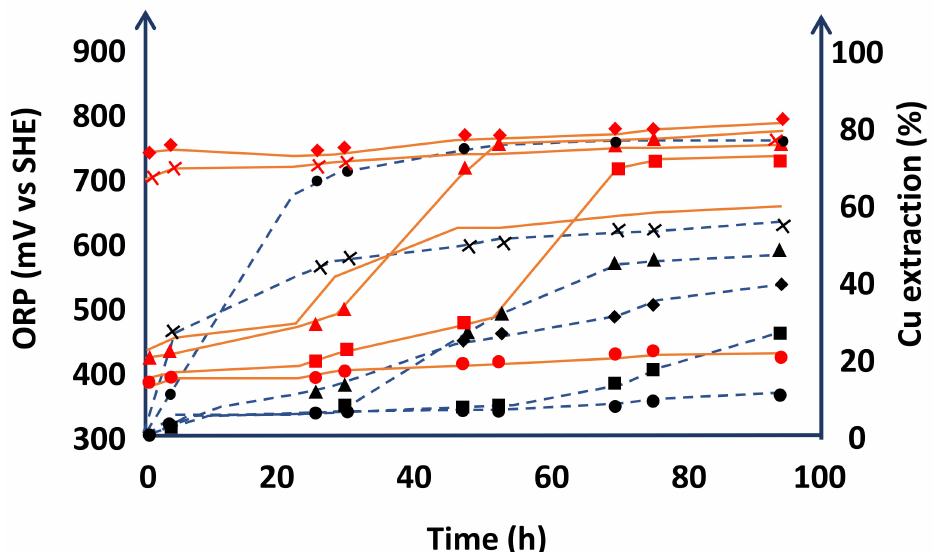
Figure 5. Dissolution of chalcopyrite concentrate and averaged ORP (mV vs. Ag/AgCl) values over time (hours) for Series I at different concentrations of H 2 SO 4 and NaNO3. (o) Test 1 (H 2 SO 4 = 0.1 M and NaNO 3 = 0.1 M); (•) Test 2 (H 2 SO 4 = 0.1 M and NaNO 3 = 0.5 M); (N) Test 3 (H 2 SO 4 = 0.5 M and NaNO 3 = 0.1 M); (•) Test 4 (H 2 SO 4 = 0.5 M and NaNO 3 = 0.5 M); (X) Test 5 (H 2 SO 4 = 1.0 M and NaNO 3 = 0.1 M); (_) Test 6 (H 2 SO 4 = 0.5 M and NaNO 3 = 0 M). (Test conditions: 94 h, P80 = 60.66 µm, 450 rpm and room temperature). The copper recoveries are shown with black dotted line in axis secondary and averaged ORP values are shown with red dotted line (Modified from: [44]).